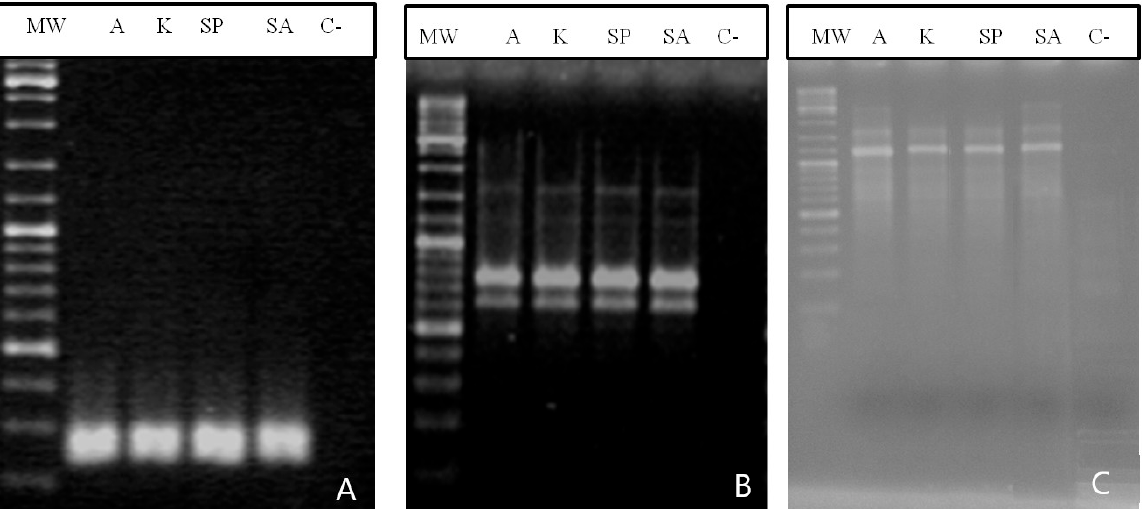
Figure 1. Bands patterns of individual gDNA representing different geographic areas. ( A ) SSR profile, ( B ) RAPD profile and ( C ) SRAP profiles. MW: Molecular weight (1 kb, Promega); A: C. sativus from Abruzzo (Italy); K: C. sativus from Kozani (Greece); SP: C. sativus from Spain; SA: C. sativus from Sardinia (Italy).